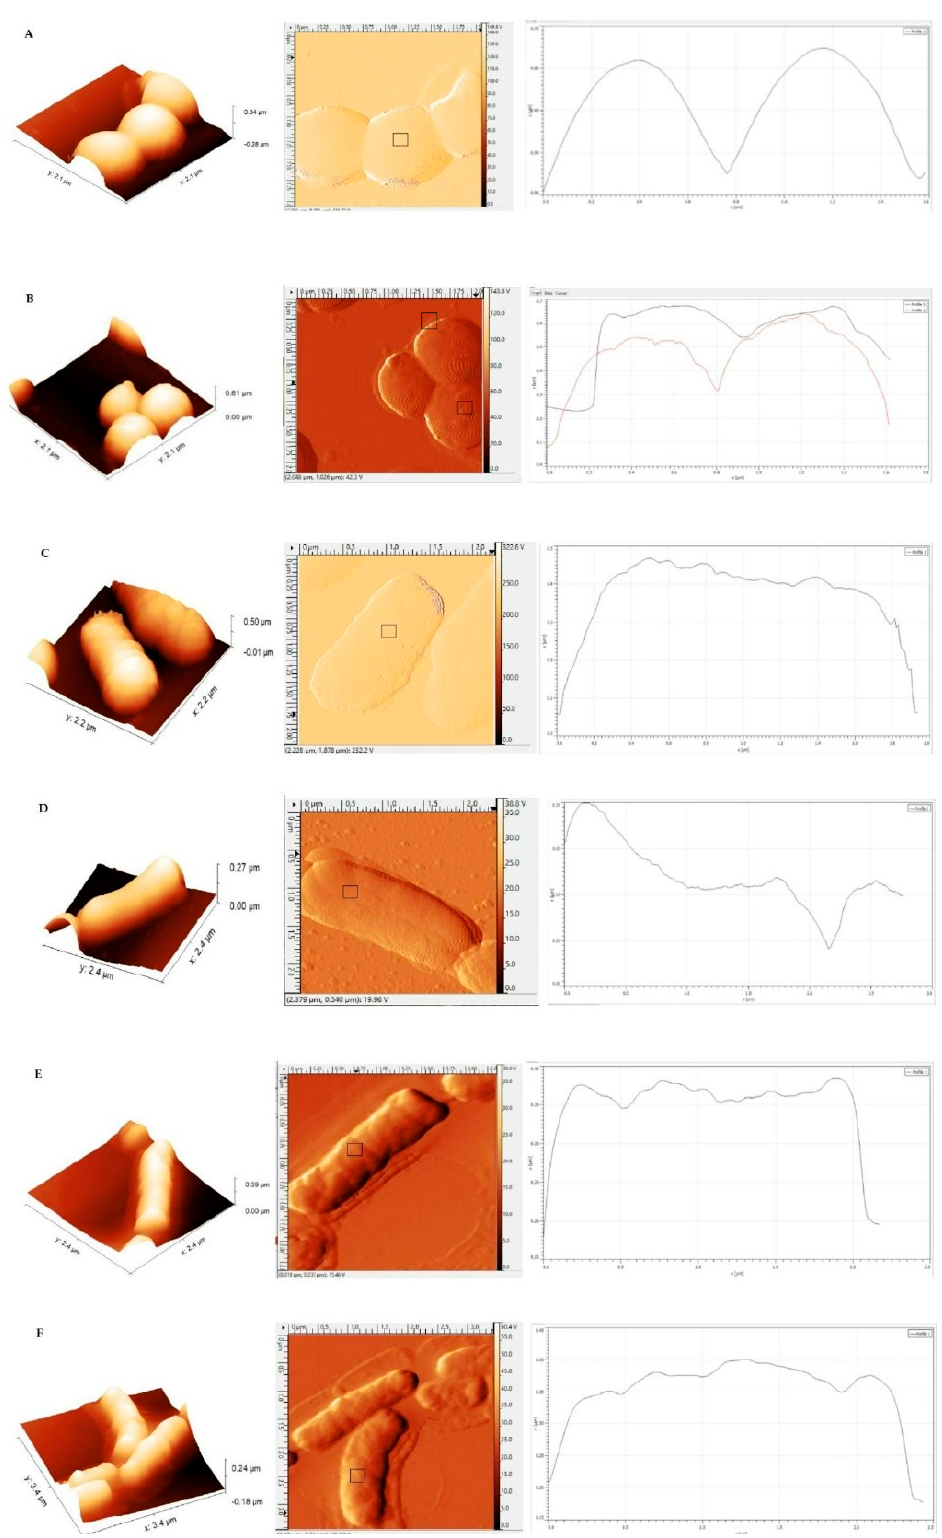
Figure 6. AFM 3 D image projections (left), AFM error images (middle) and AFM profile (right) S. epidermidis in the absence of the nanoparticles ( A ); S. epidermidis incubated overnight with 50 mg/L MIP nanoparticles ( B ); E.coli in the absence of the nanoparticles ( C ); E.coli incubated with 50 mg/L MIP nanoparticles ( D ); B. subtilis in the absence of the nanoparticles ( E ); B. subtilis incubated overnight with 50 mg/L MIP nanoparticles ( F